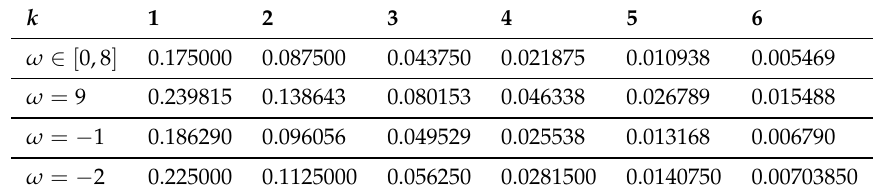
Figure 1. Error bounds of binary scheme (Equation (3)). Table 1. Binary scheme error bounds.